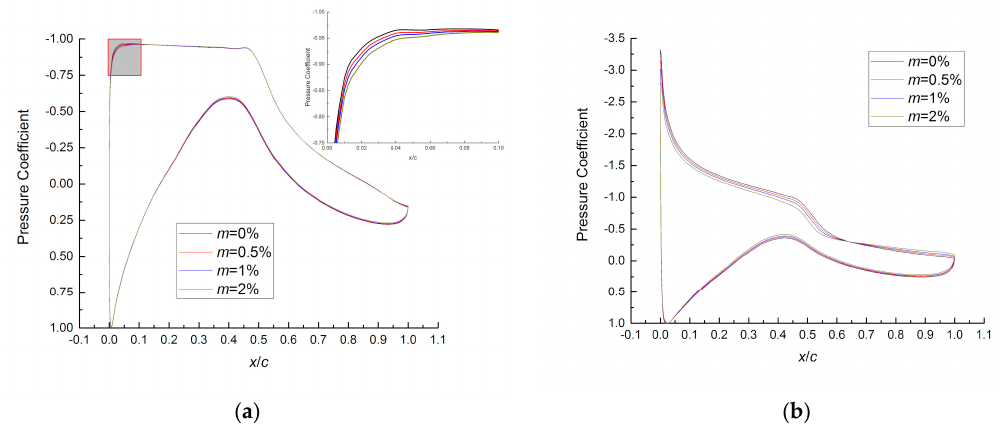
Figure 10. Particle concentration effects on pressure coefficient distribution over S809 airfoil at Re = 1 × 10 6 : ( a ) α = 4.1°; ( b ) α = 9.1°.